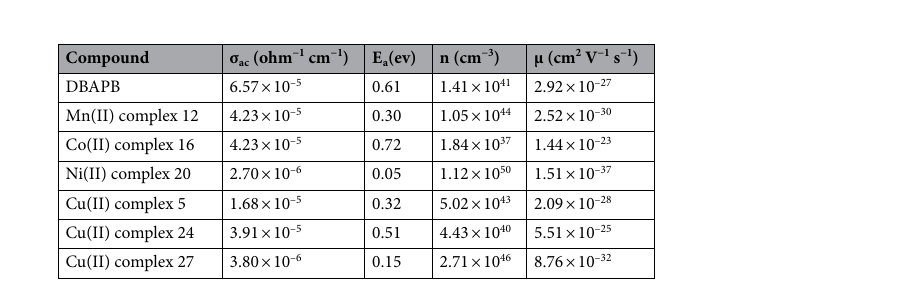
Table 11. Electrical properties of the ligand, DBAPB, and its complexes 5, 12, 16, 20, 24, 27 at 308